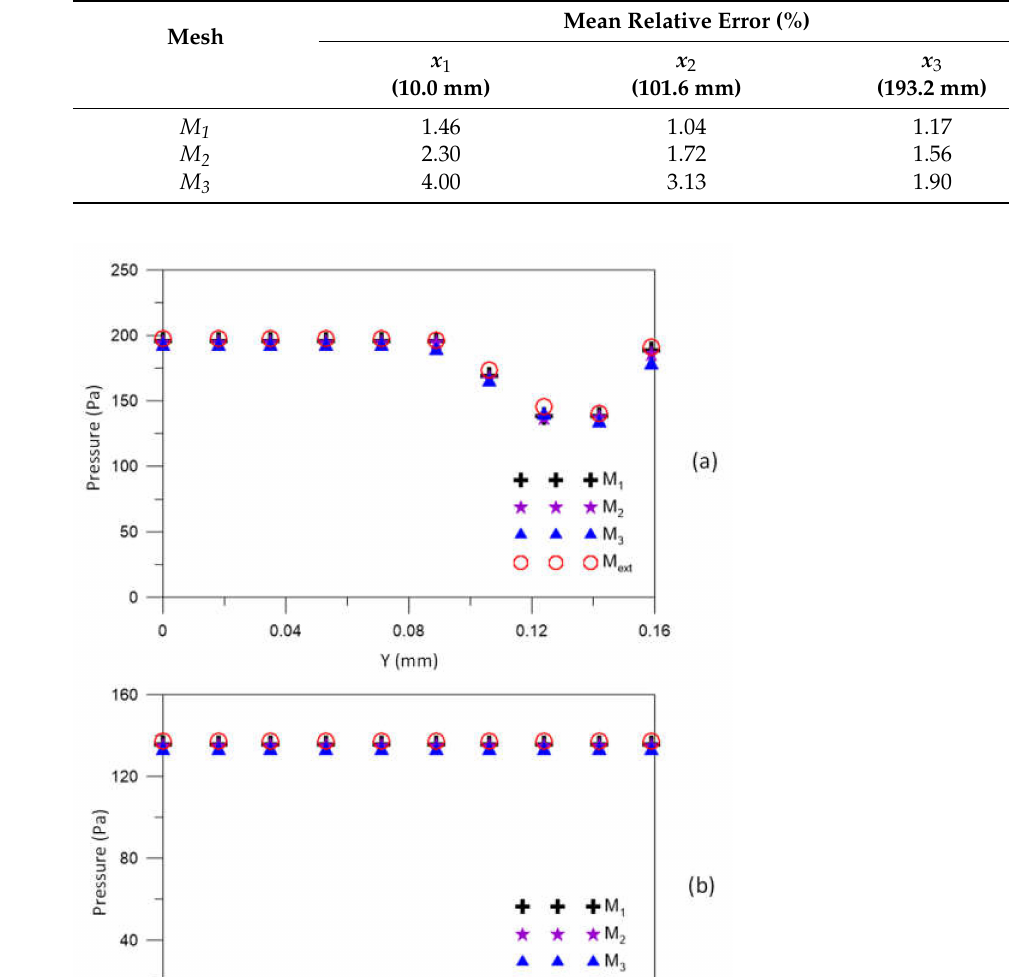
Table 9. Mean relative error compared to extrapolated mesh.